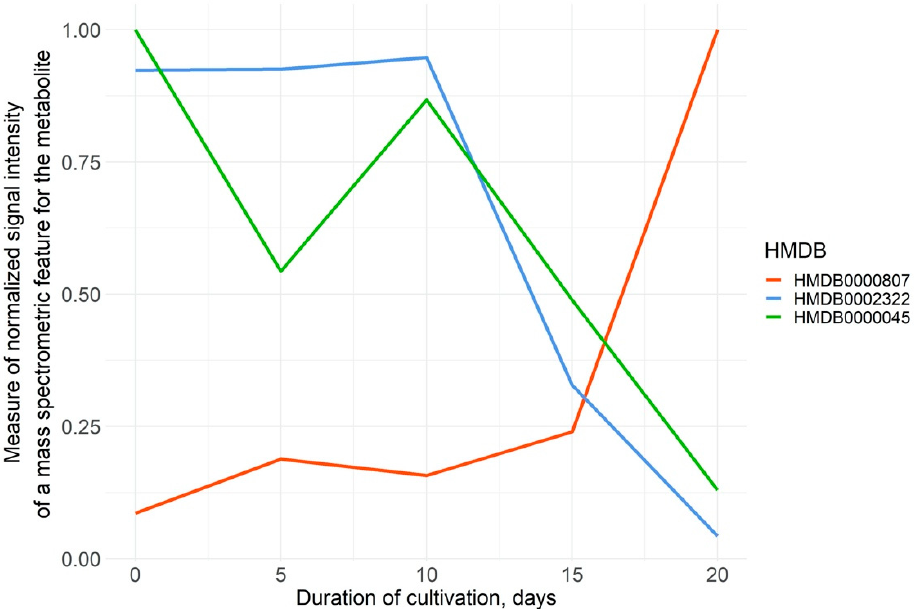
Figure 3. Dynamics of normalized mean intensities of m/z features of the corresponding metabolites (3-phosphoglyceric acid, HMDB0000807—red, cadaverine, HMDB0002322—blue, adenosine monophosphate, and HMDB0000045—green) at five time points.